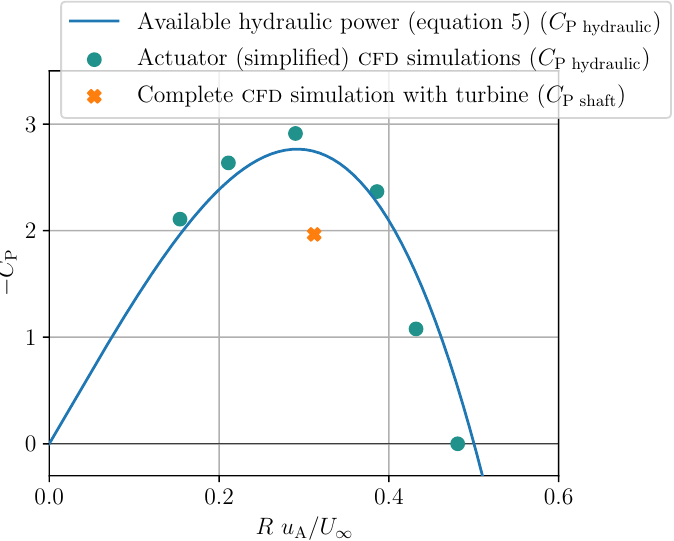
Figure 6. Modeled power curve for the WVPP . The right-most data point and the blue curve are these from Figure 5. The other green points are generated using further simplified simulations from which energy is extracted summarily in the main basin. The orange cross indicates the turbine shaft power coefficient obtained in a complete CFD simulation for conditions very close ( h 1 = 0.85m, h 2 = 0.74m) to those used when plotting the power